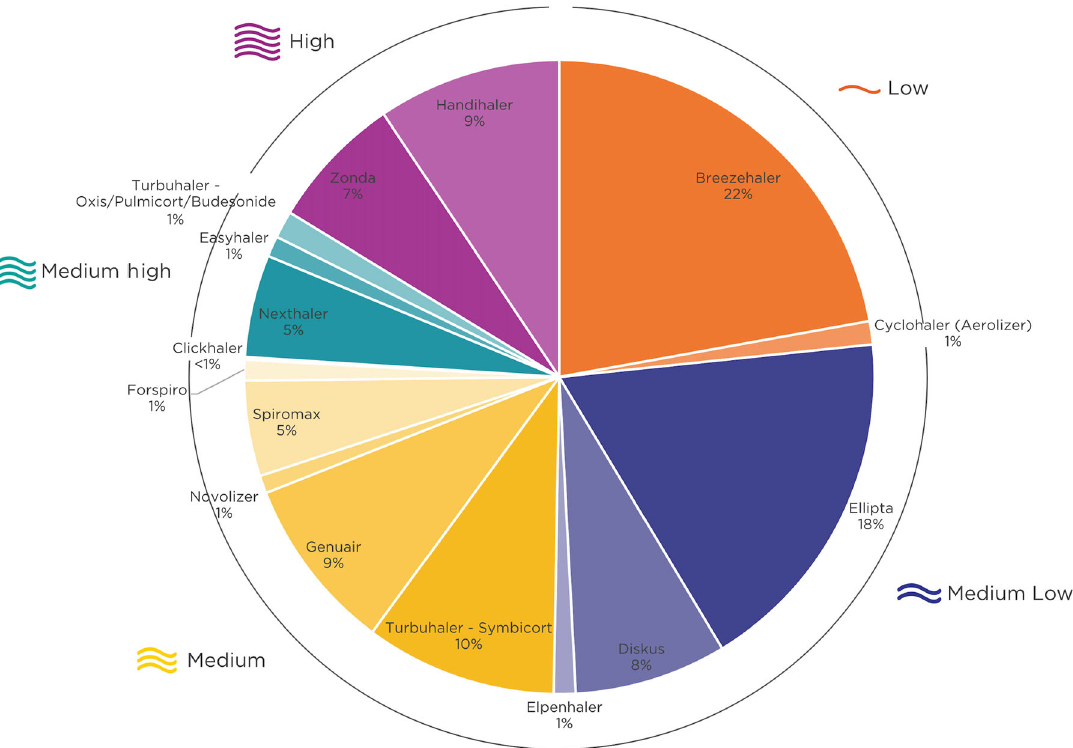
Fig. 2 Distribution of the inhaler resistance clusters and inhaler type at the moment of study visit. Primary inhaler of each participant ( n = 1434) is